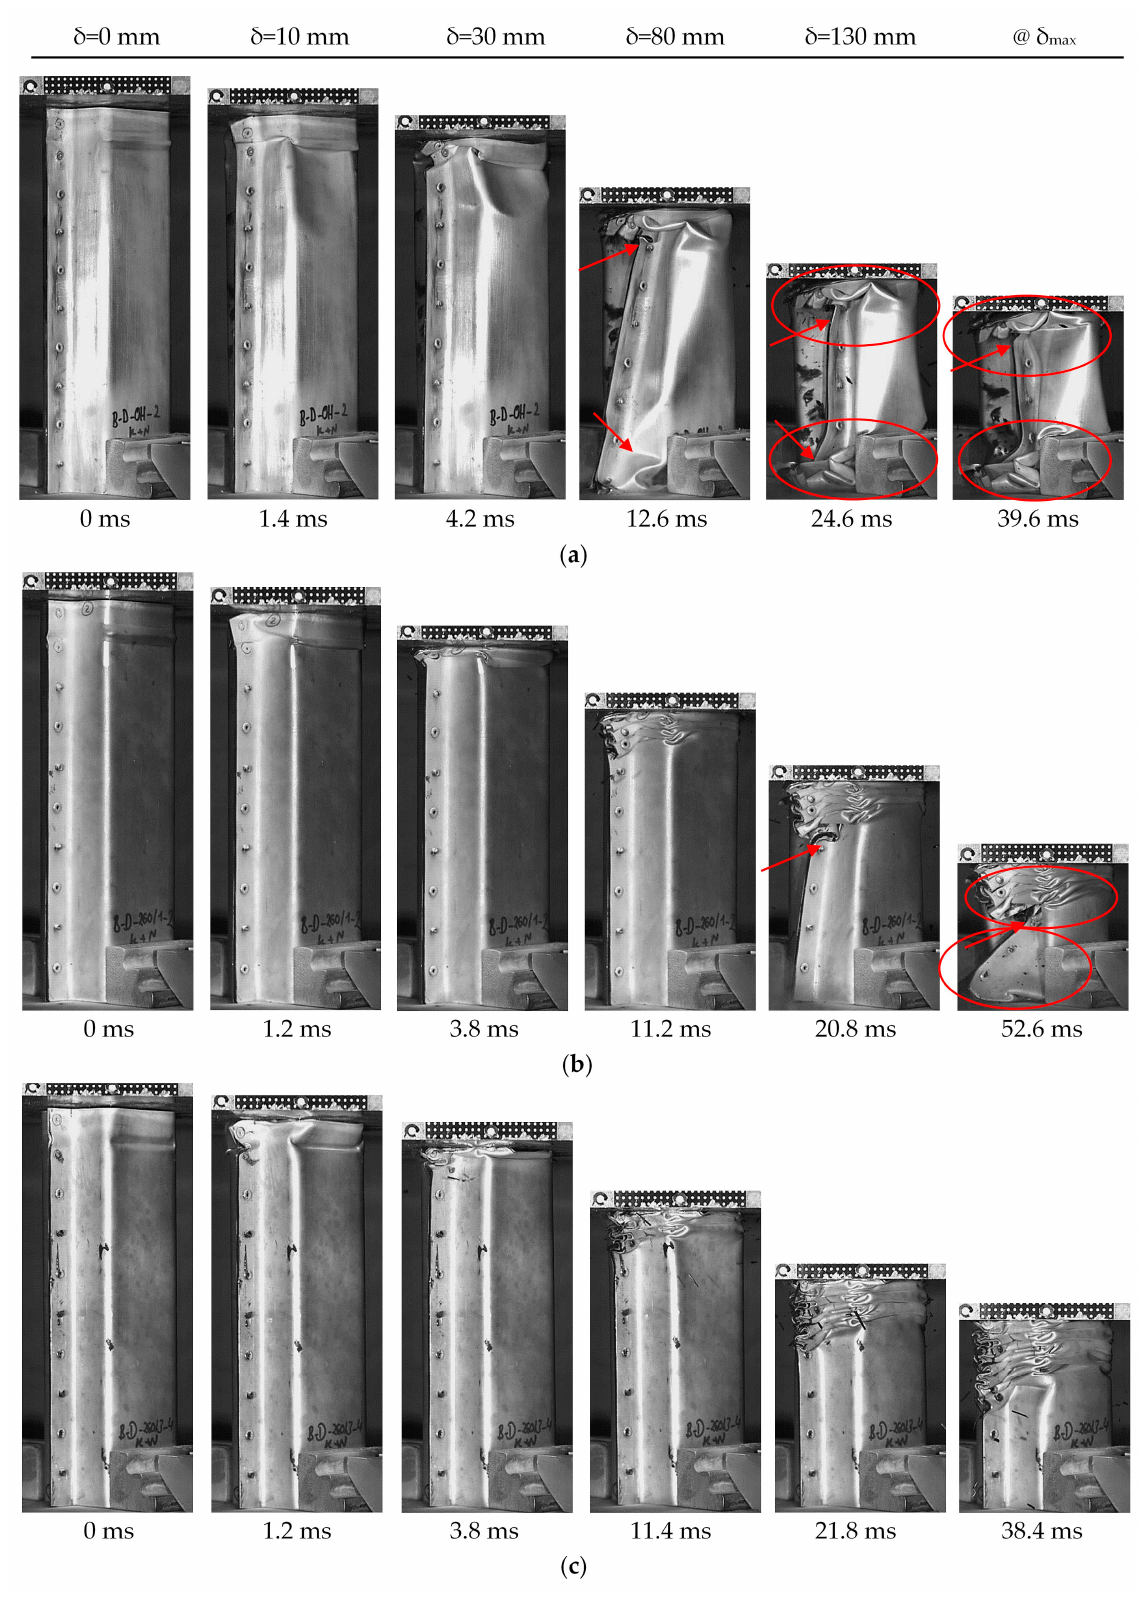
Figure A2. Photographic presentation of the dynamic collapse progress at different time steps for the double-hat crashboxes ( a ) without, ( b ) with weak, and ( c ) with strong adhesion strength.